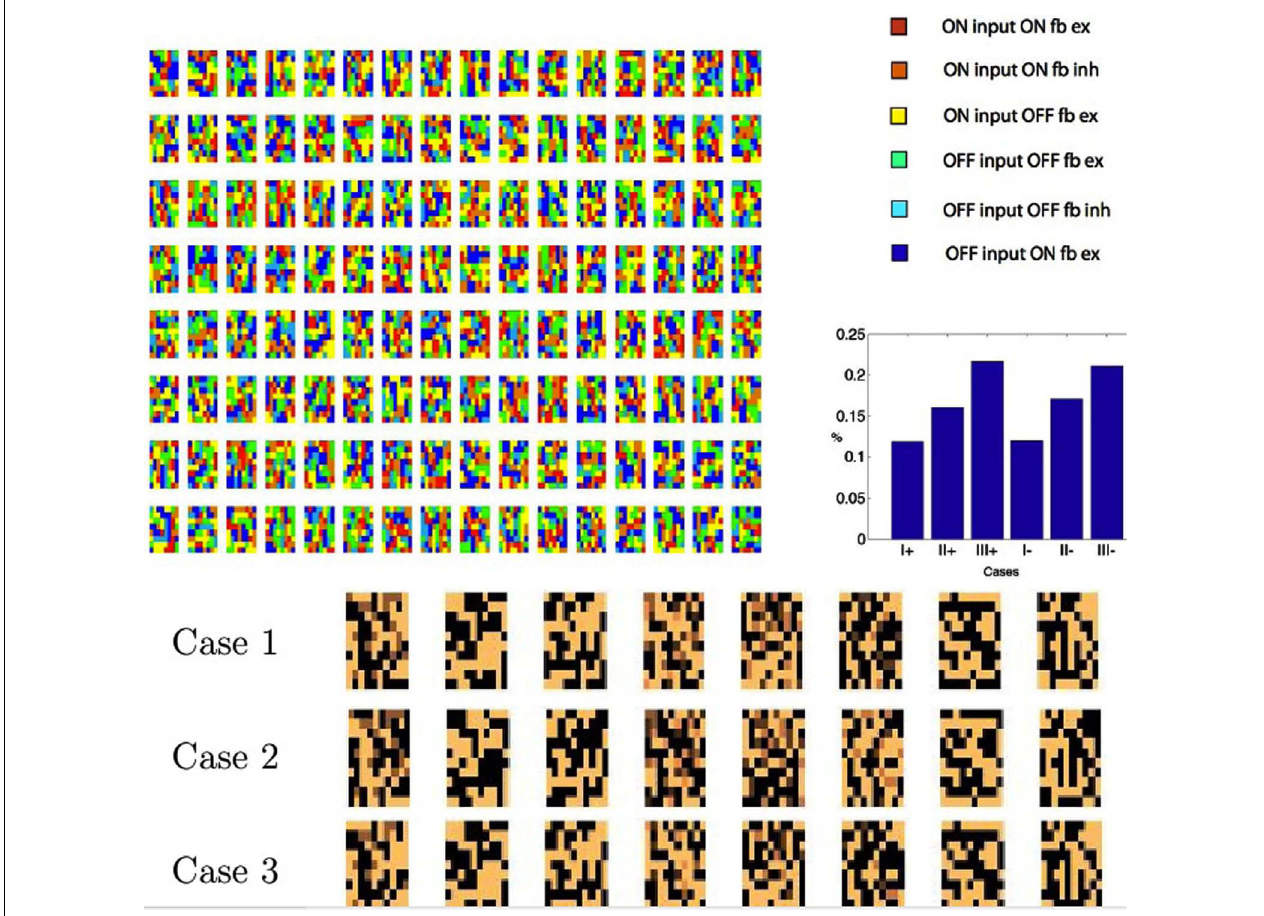
The colors show that all six cases are realized.Top right: a histogram of the frequency of usage of the different cases. Bottom: a small segment of 32 applications of learning shows the beginnings of synapse learning. 10 × 10 maps of the combined connection strengths to the LGN cells are